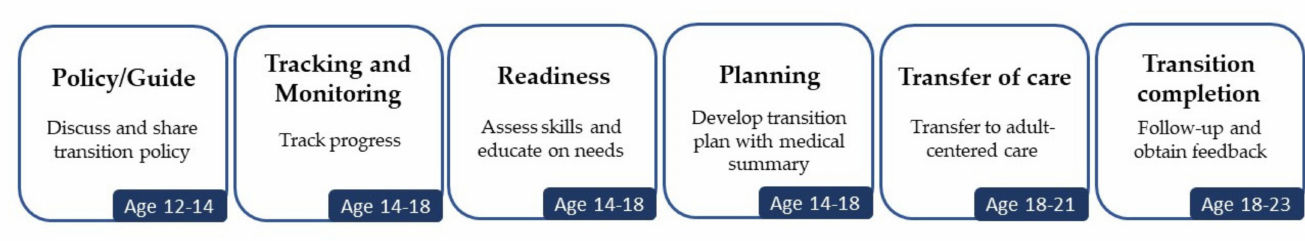
Figure 1. The Six Core Elements by Got Transition which define the basic components of a structured transition